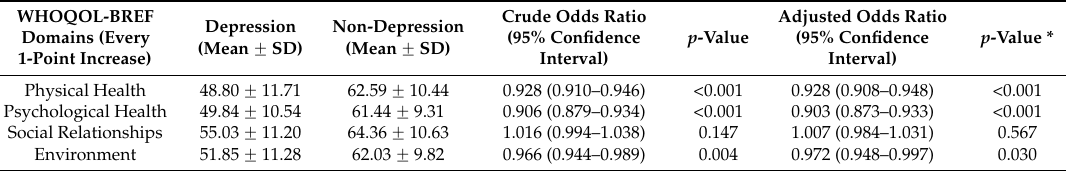
Table 5. Logistic regression analysis of QOL and